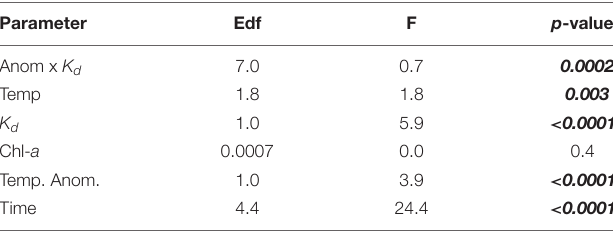
TABLE 2 | Influence of temperature, water clarity- K d and chl- a on the surface cover of Macrocystis pyrifera as determined by General additive models (GAM). Parameter